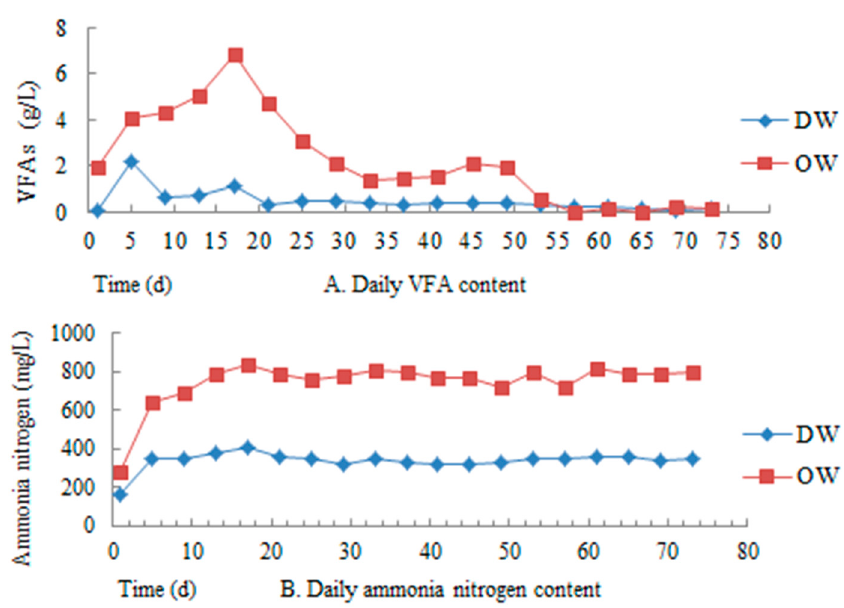
Figure 11. The change in VFA and ammonia nitrogen content under di ff erent conditions.